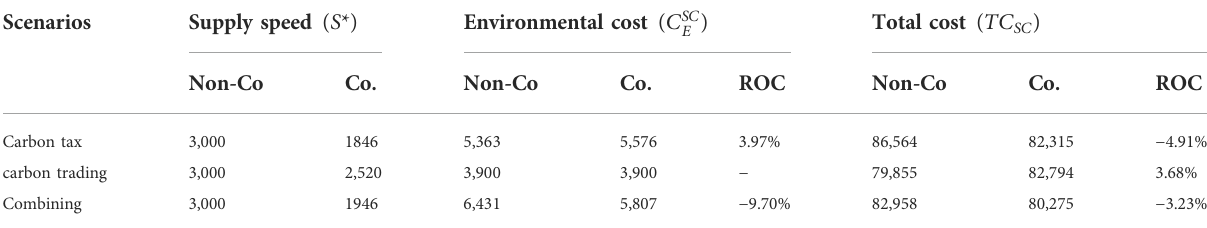
TABLE 6 Data comparison of the three